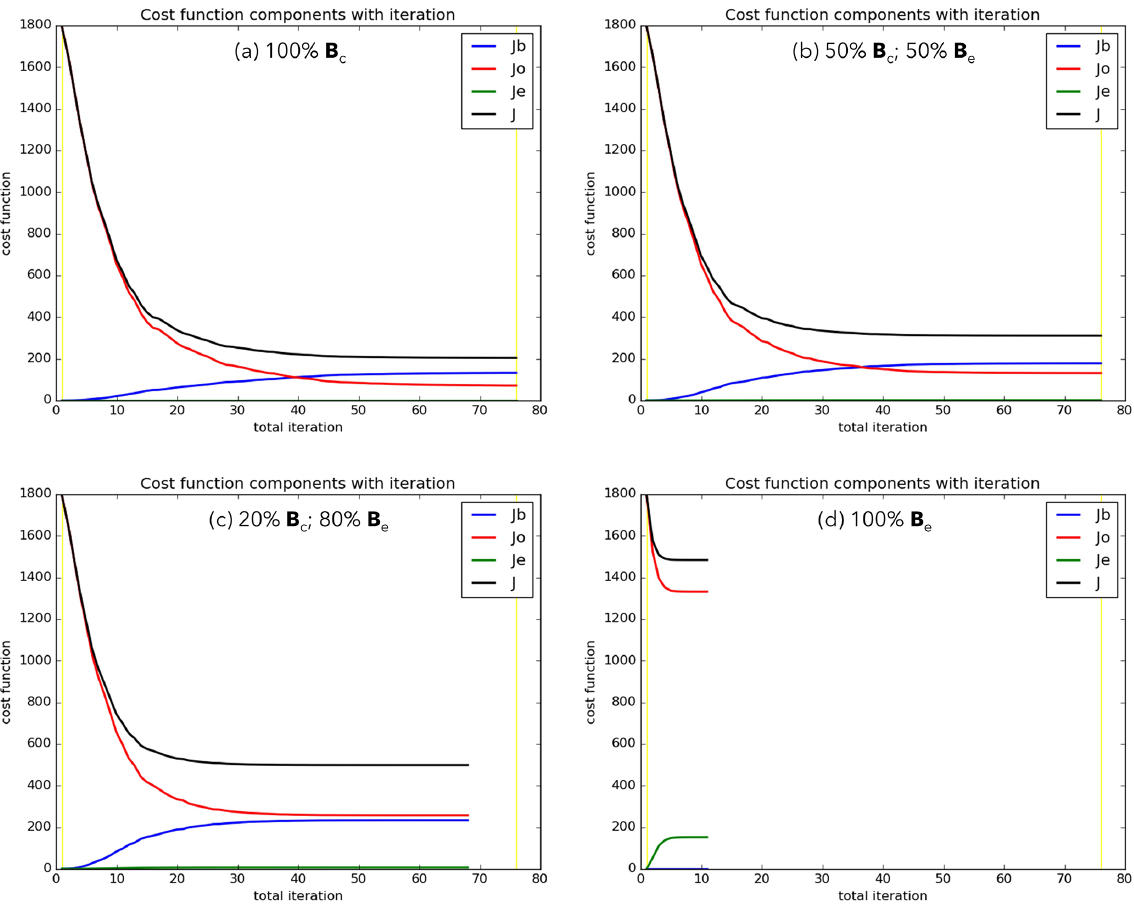
Figure 4. Total penalty (black) from the climatological background (blue), ensemble background (green), and observation (red) penalty contributions over the 75 inner loops for the first cycle of the EBV experiments, labelled (a) to (d) accordingly. Early termination of inner loops occurs when convergence criteria is satisfied, in (c) and (d) . At convergence, ensemble penalty (green) in (b) and (c) is around 1.5 and 7,